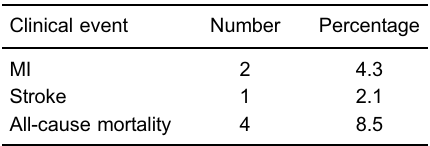
Table 2. Follow up of adverse events (six